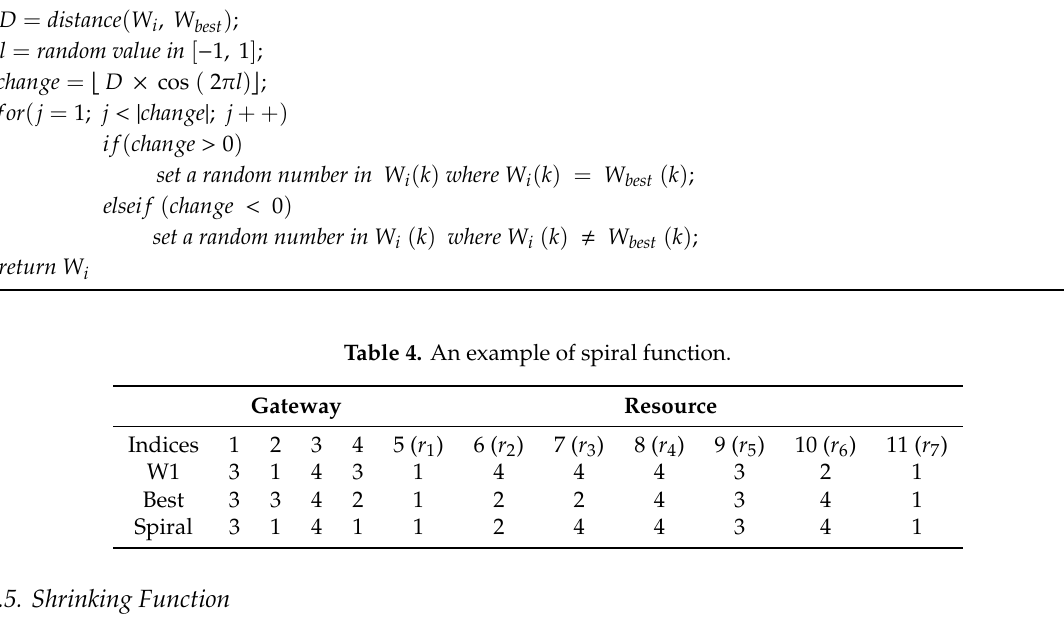
Algorithm 2: spiral W i round W best